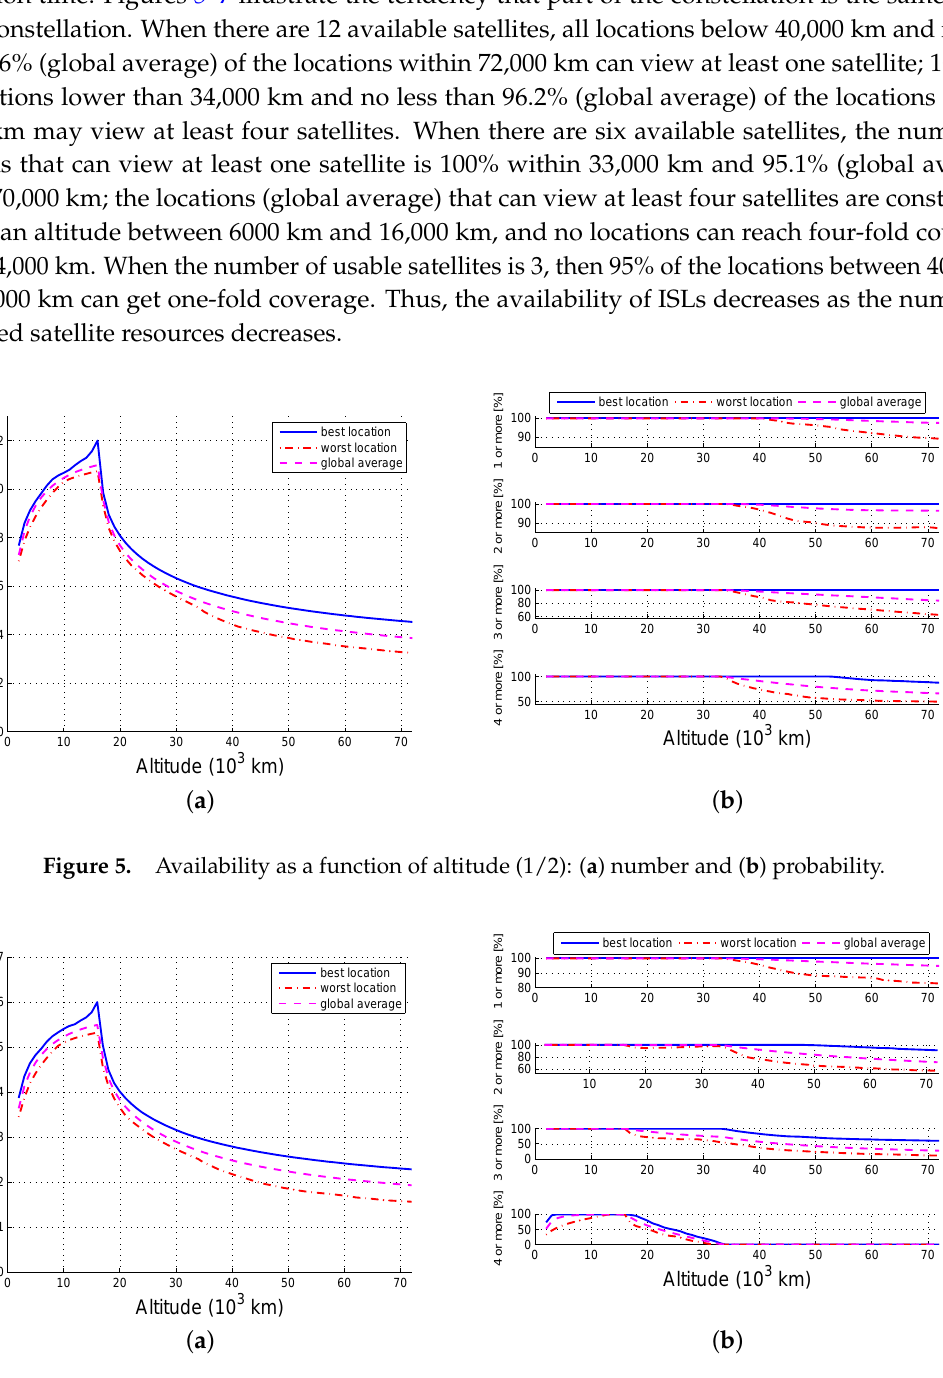
Figure 6. Availability as a function of altitude (1/4): ( a ) number and ( b )